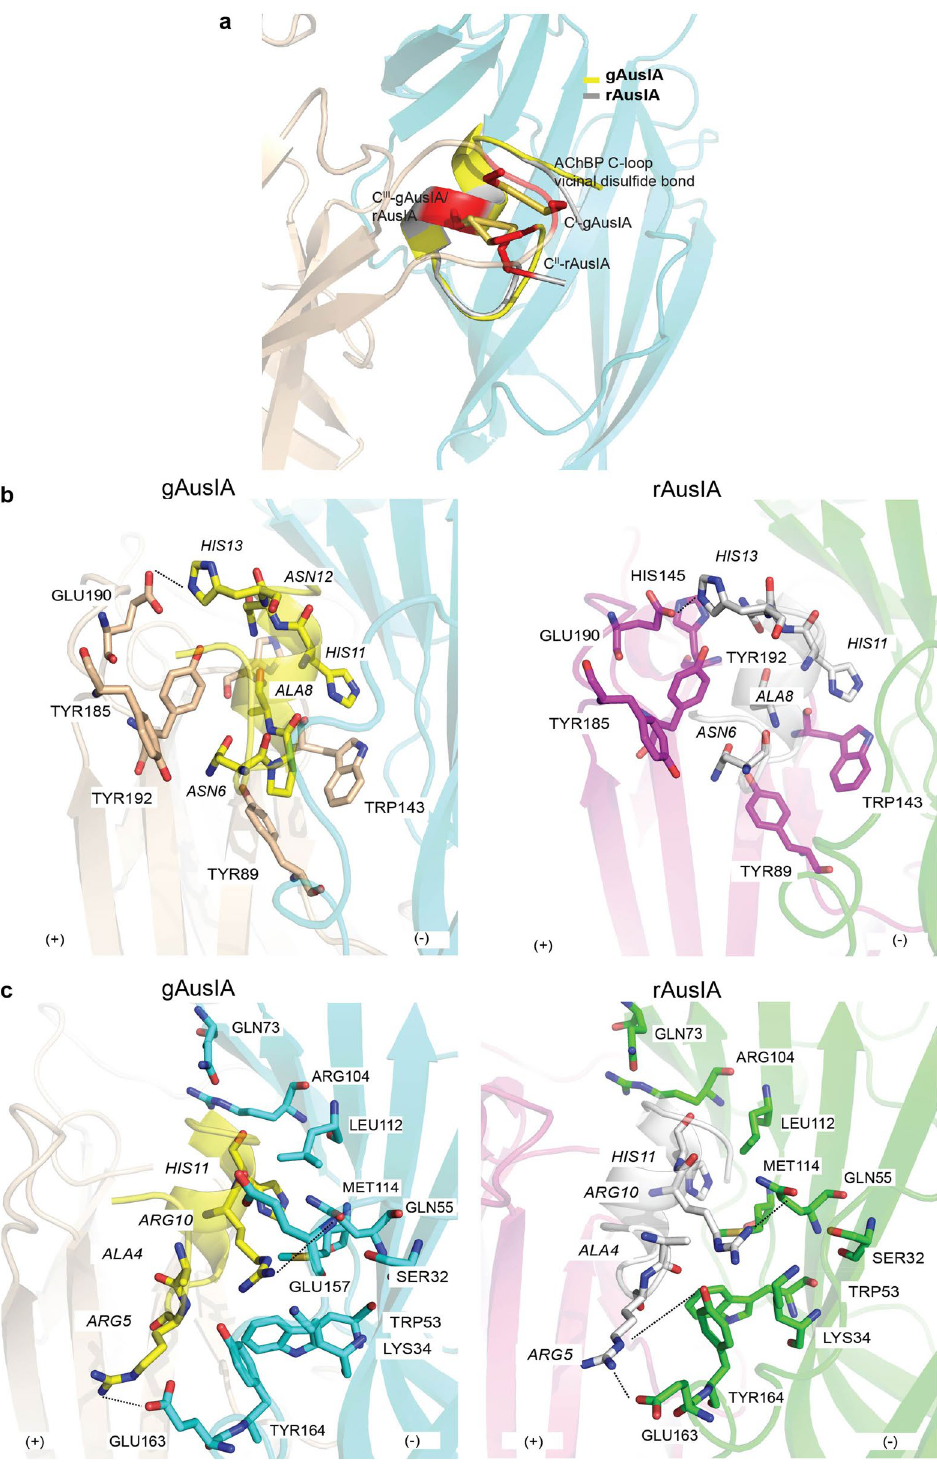
Figure 2. Binding interface between gAusIA/rAusIA with Ls -AChBP. (a) The stacking of disulfide bridges between Cys I -Cys III of gAusIA and Cys II -Cys III of rAusIA and Cys187-Cys188 of Ls -AChBP. gAusIA and rAusIA display similar pairwise interactions with Ls -AChBP. On the principal side ( b ), most contacts comprise conserved aromatic side-chain residues, particularly a hydrogen bond (dash line) formed between His13 and Glu190. On the complementary side ( c ), interactions are dominated by hydrogen bonds, specifically between Arg5 and Glu163, and Arg10 and Gln55. AusIA residues are in italics. Interaction distances are listed in Supplementary Table